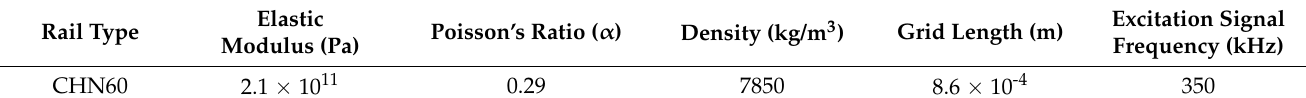
Table 1. Simulation parameters.